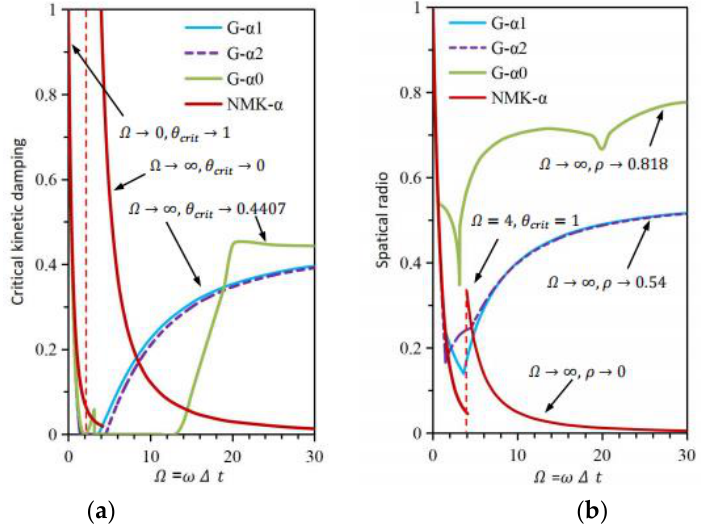
Figure 6. Critical kinetic damping 𝜃 𝑐𝑟𝑖𝑡 of the referred methods: ( a ) 𝜃 𝑐𝑟𝑖𝑡 by the sampling fre- Figure 6. Critical kinetic damping θ crit of the referred methods: ( a ) θ crit by the sampling frequency Ω ; quency 𝛺 ; ( b ) spectral radius by the 𝜃 𝑐𝑟𝑖𝑡 . ( b ) spectral radius by the θ crit .